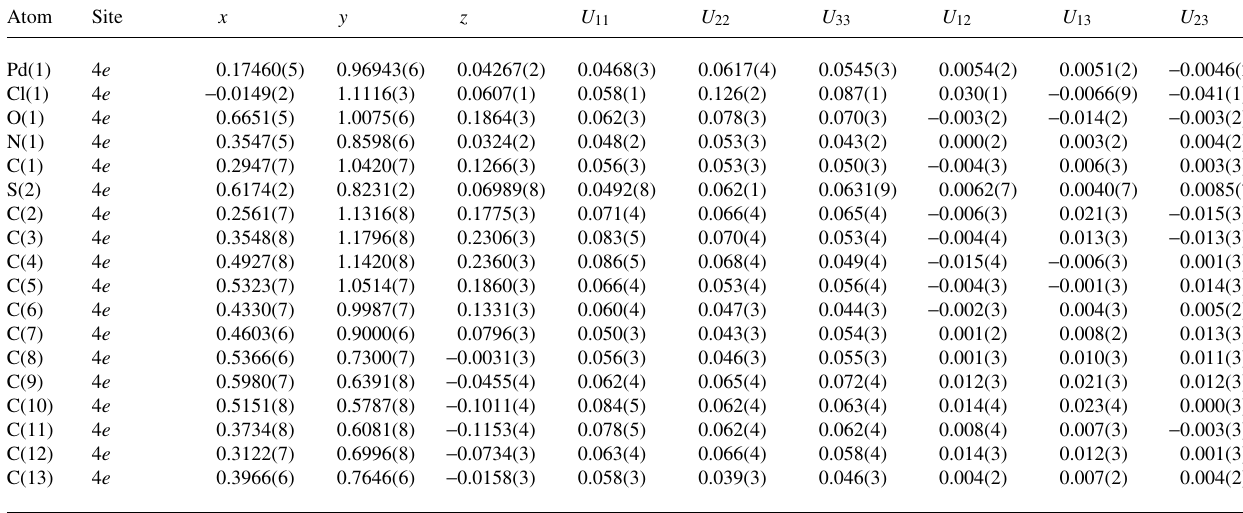
Table 3. Atomic coordinates and displacement parameters (in Å 2 ) .